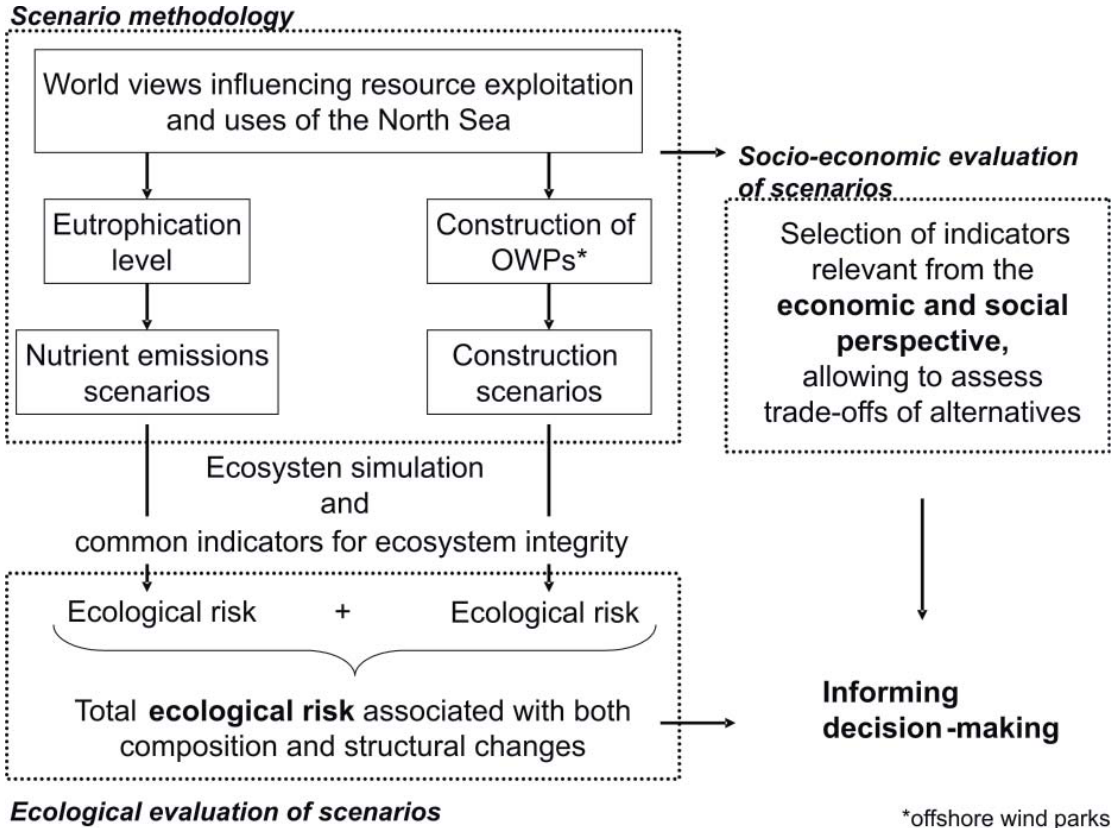
Figure 1. Theoretical approach for combining the ‘ecological risk‘ resulting from different issues as described through different scenarios. The assessment of risk should include the appraisal of scenario socio-economic components (in terms of costs and benefits) in order to allow the identification of trade-offs and thereby the determination of acceptable